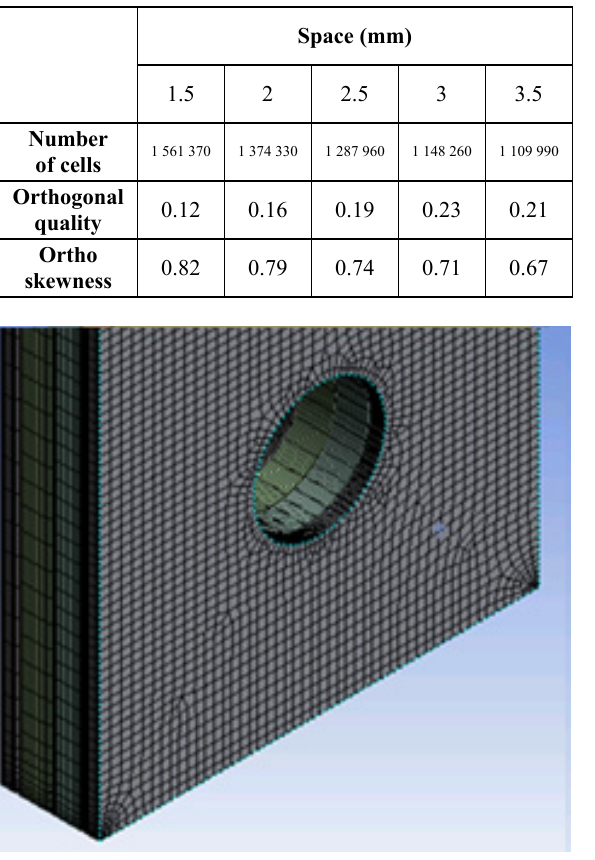
Fig. 4. Meshed model.